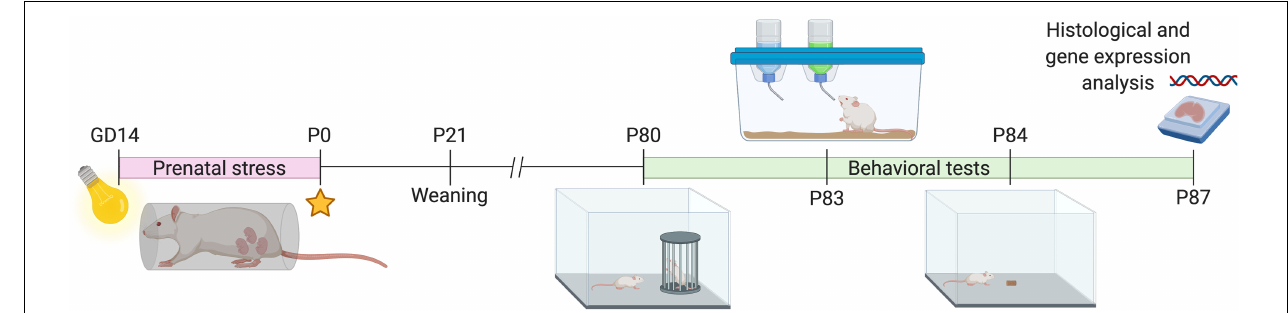
FIGURE 1 | Schematic drawing of the experimental timeline. GD, gestational day; P, postnatal day. Cartoons for behavioral tests represent the following: P80, social investigation test; P83, sucrose preference; P84, novelty-suppressed feeding test.